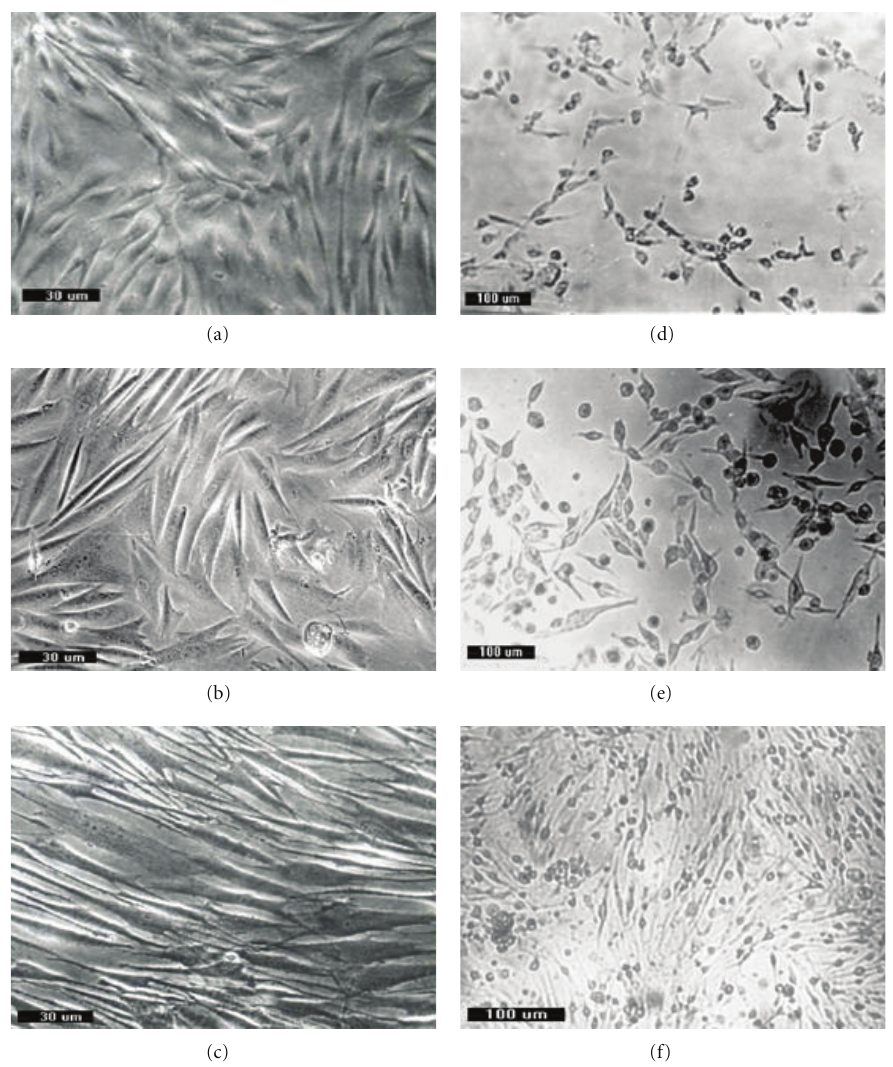
Figure 2: Morphological changes in cultured fibroblasts recorded by light microscopy. (a) SIG, normal fibroblasts showed active cell proliferation. (b) LDG1, single irradiation of 7.2 J/cm 2 UVA caused no significant e ff ect on cell morphology and cell proliferation. (c) LDG5, repetitive irradiation of 7.2J/cm 2 UVA at a total dose of 115.2 J/cm 2 caused large cell volume, increased intracellular particles, and inhibited cell proliferation. (d) HDG, 12 h after 86.4 J/cm 2 UVA irradiation: massive apoptotic death was observed. (e) ARG1, 3h after single low-dose UVA preirradiation: atomic and death of fibroblasts caused by sequential 86.4 J/cm 2 UVA irradiation was reduced. (f) ARG5, 3 h after repetitive irradiation of 7.2 J/cm 2 UVA at a cumulative dosage of 115.2 J/cm 2 , death of fibroblasts caused by subsequent 86.4 J/cm 2 UVA irradiation was reduced